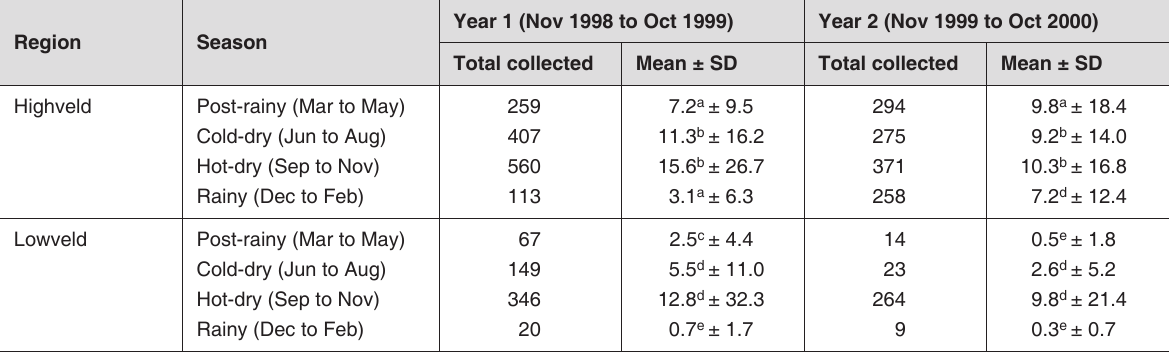
Figures with a different superscript within a column or row are significantly different at P < 0.05 SD = Standard